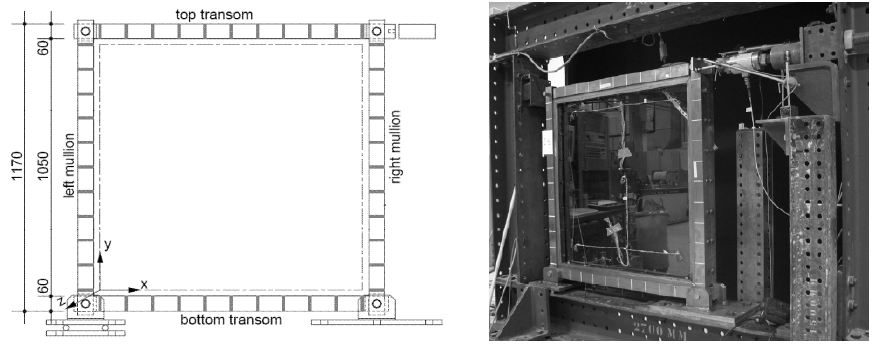
Figure 6: Drawing and photo of the test set-up